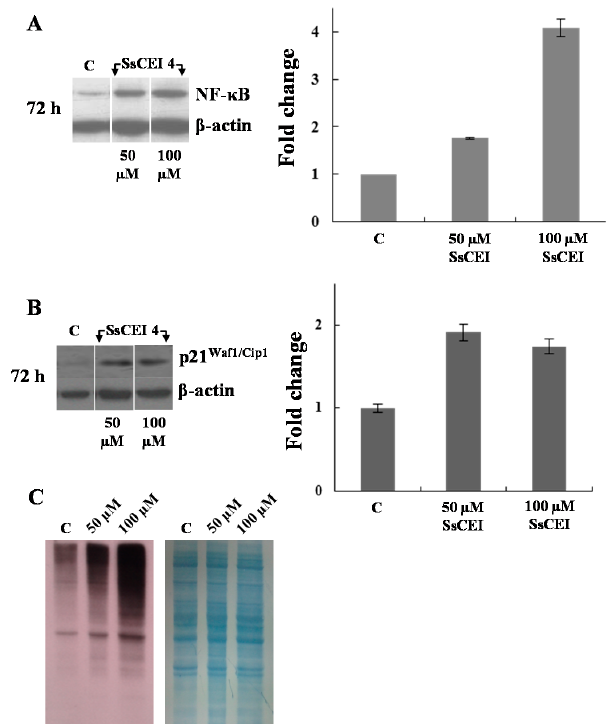
Figure 5. SsCEI 4 treatment of U2OS induces an increase of the classical hallmarks of the proteasome inhibition. Representative immunoblots of NF- κ B ( A ) and p21 Waf1/Cip1 ( B ) in U2OS cells exposed to SsCEI 4 (50 and 100 µM) for the indicated time intervals. Data were normalized to the density of control protein ( β -actin). The values were expressed as average relative intensity as compared to untreated cells (C) and expressed as means ± SD of measurements performed in triplicate; ( C ) Polyubiquitinated proteins in U2OS cells untreated (C) and treated with SsCEI 4 for 72 h. After immunodetection, the polyvinylidene difluoride (PVDF) membrane was stained with Coomassie blue.